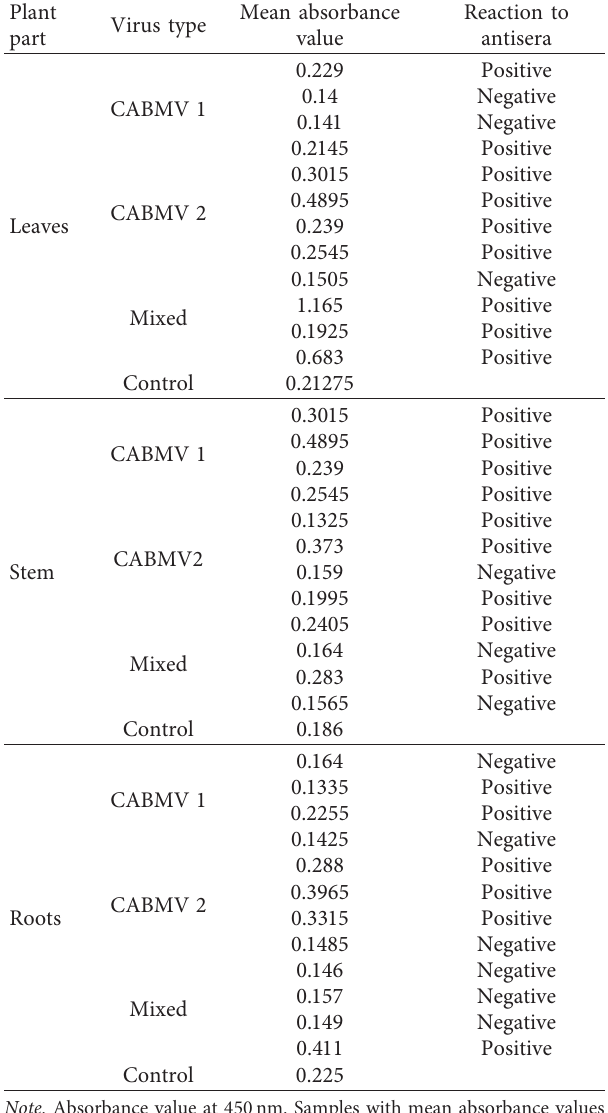
Table 4: Determination of CABMV isolate distribution in P. edulis by DAS-ELISA, absorbance value for CABMV assay indicates the presence or absence of the virus in different